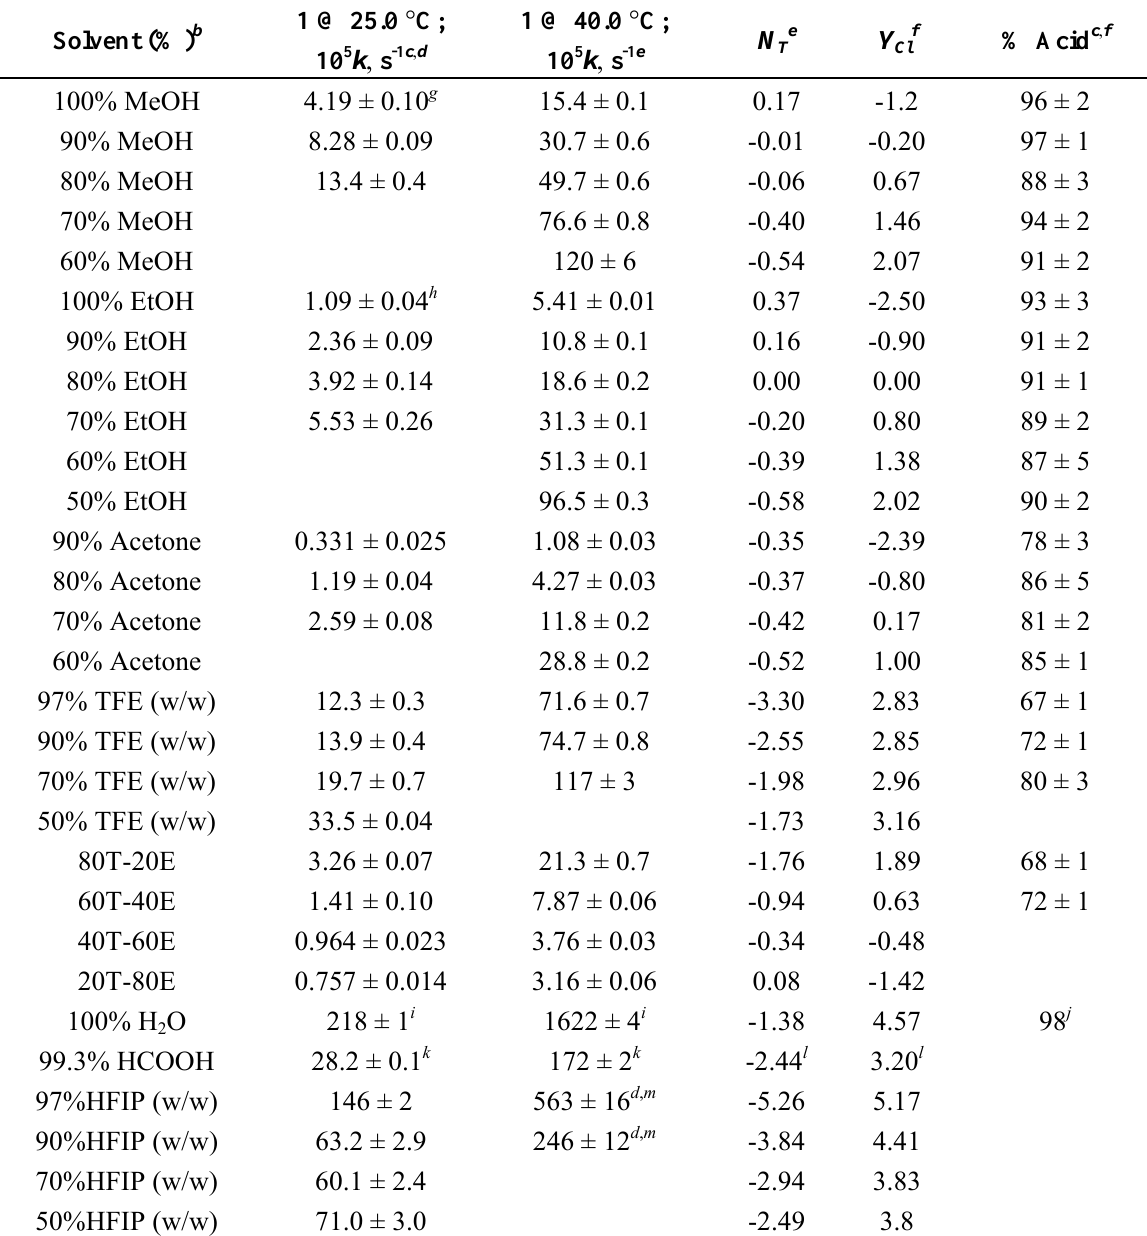
Table 1 . Specific rates of solvolysis ( k ) a of 1 , in several binary solvents at 25.0 ºC and 40.0 ) and ( Y ); and the percentages of overall reaction proceeding °C; literature values for ( N T Cl with acid formation at 40.0